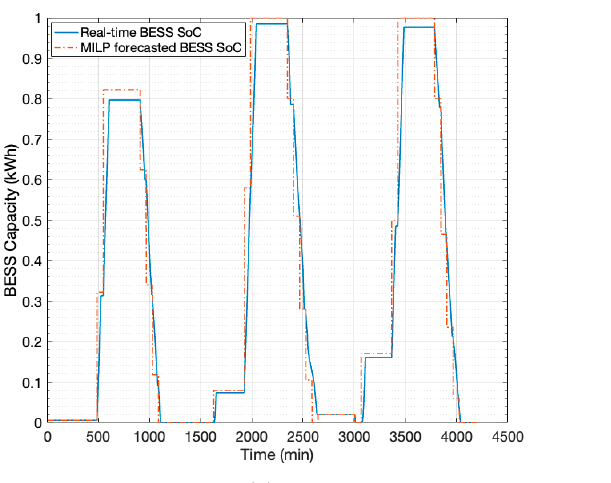
Figure 9. Extract of the BESS SoC curve (purple) over the same 6-days period for REC R1234 ( a ) and R2345 ( b ) configurations.